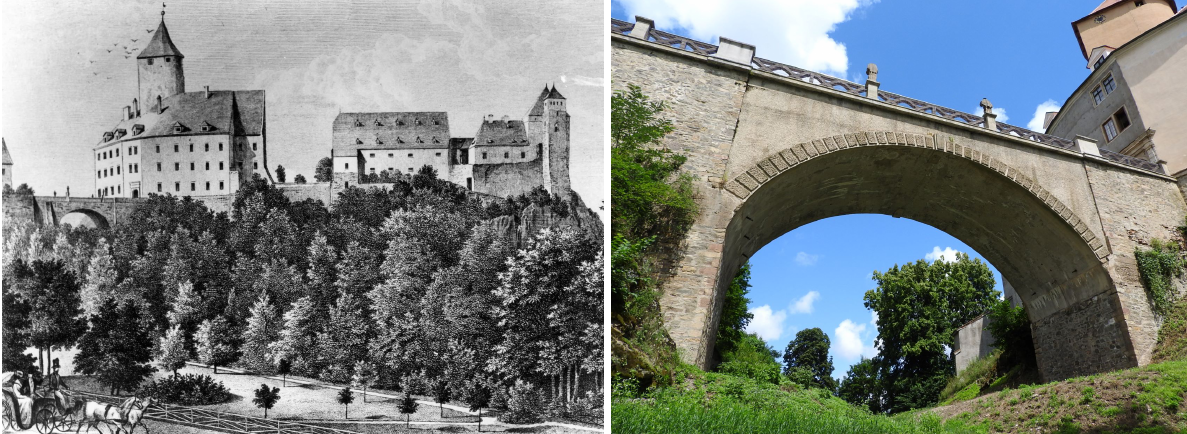
Figure 2. Bridge over rocky gorge at the castle Veveří near Brno, 1898 (left – former masonry bridge [2], right – concrete bridge at